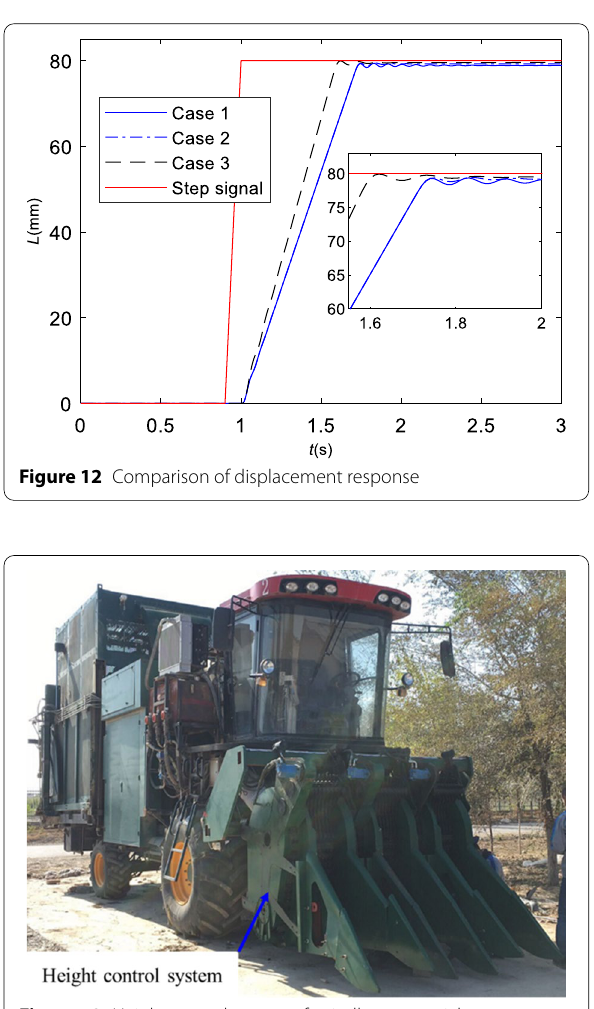
Figure 13 Height control system of spindle cotton